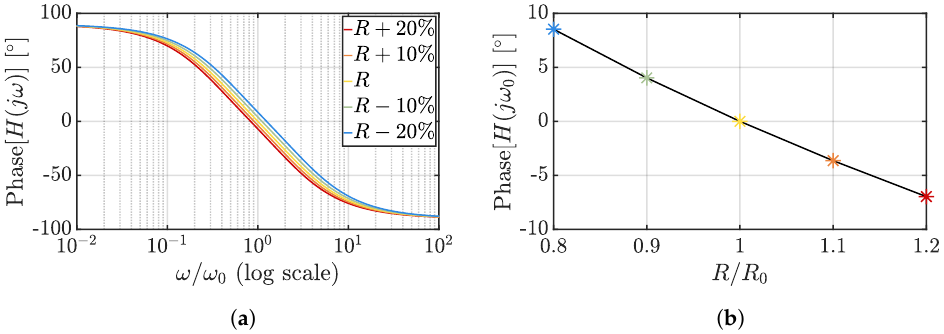
Figure 8. Phase dependency on resistance variations for a Wien-bridge filter: impact on the phase response of the filter ( a ) and phase shift at ω 0 as a function of the resistance variation ( b